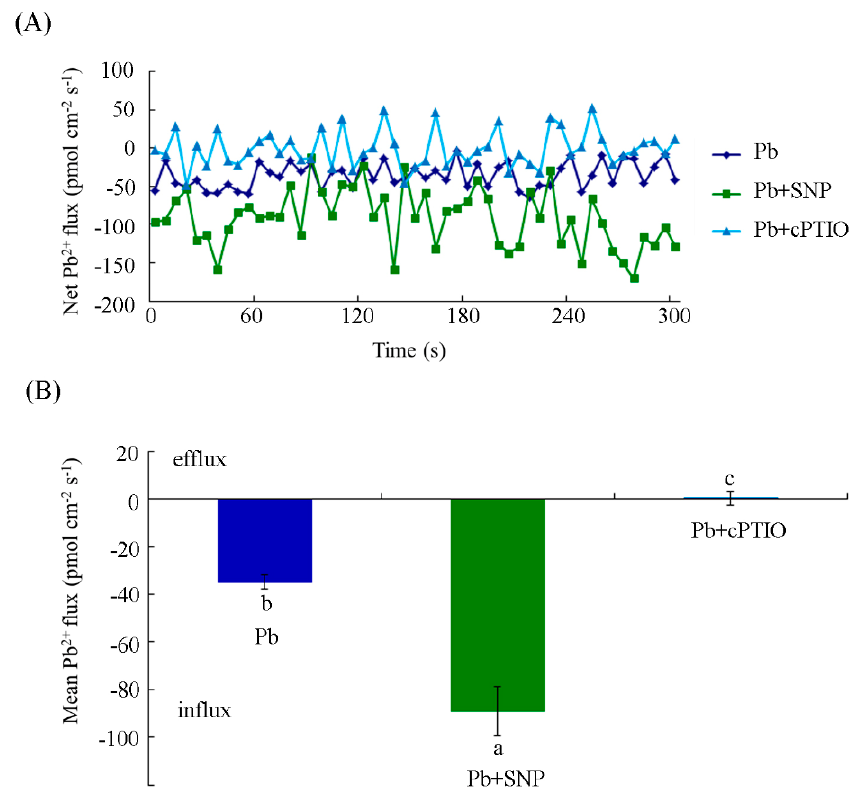
Figure 6. E ff ects of NO on Pb 2 + fluxes in tobacco BY-2 cells after di ff erent treatments for 10 h. ( A ) Net Figure 6. Effects of NO on Pb 2+ fluxes in tobacco BY-2 cells after different treatments for 10 h. ( A ) Pb 2 + fluxes in tobacco BY-2 cells incubated with 250 µ M Pb(NO 3 ) 2 alone, with 0.5 µ M SNP, or with Net Pb 2+ fluxes in tobacco BY-2 cells incubated with 250 μ M Pb(NO 3 ) 2 alone, with 0.5 μ M SNP, or 100 µ M cPTIO. ( B ) The mean rate of Pb 2 + fluxes in tobacco BY-2 cells treated with 250 µ M Pb(NO 3 ) 2 with 100 μ M cPTIO. ( B ) The mean rate of Pb 2+ fluxes in tobacco BY-2 cells treated with 250 μ M alone, with 0.5 µ M SNP, or with 100 µ M cPTIO. Di ff erent lowercase letters show significant di ff erence Pb(NO 3 ) 2 alone, with 0.5 μ M SNP, or with 100 μ M cPTIO. Different lowercase letters show ( p < significant difference ( p < 0.05).